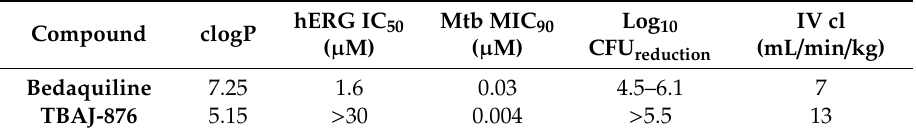
Table 1. clogP, hERG activity, antimycobacterial efficacies in vitro and in vivo, and IV mouse clearance for BDQ and its improved analog TBAJ-876.